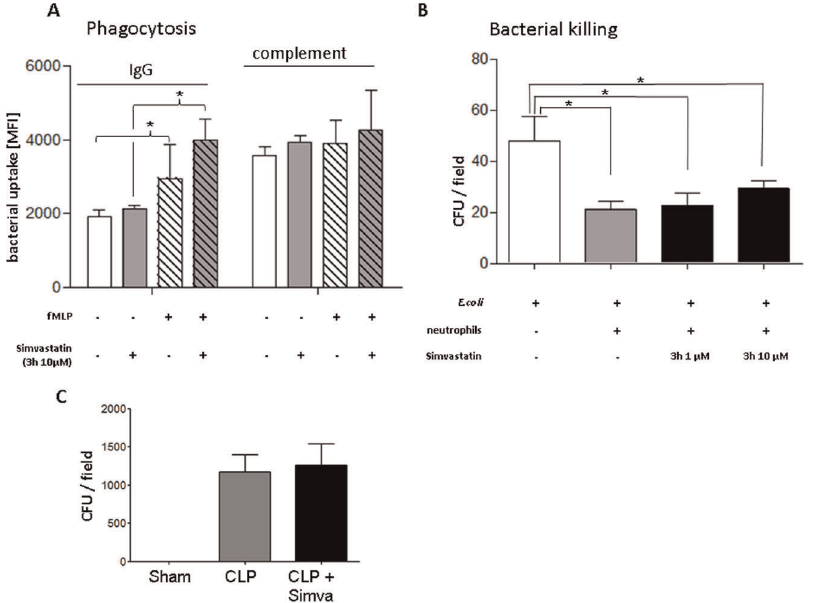
Figure 6. Simvastatin does not affect neutrophil antimicrobial activity invitro (A + B) and invivo (C). A: Bacterial uptake of fluorescent IgG- or complement-opsonized E. coli by activated or resting neutrophils as assessed by flow cytometry. Neutrophils were activated with fMLP and pretreated with simvastatin as indicated n=4; repetition=4. Statistical significance was tested using two way ANOVA with with Bonferroni posttest. * indicates significant difference to the control group without fMLP. B: Formation of colony forming units (CFU) after hypotonic lysis of neutrophils that had phagocytozed E. coli (BL21) for 20 min. (n=4). C No negative effect on neutrophil bacterial clearance in acute lung injury. 24 h after cecal ligation and puncture (CLP), the supernatant of the harvested lungs was spread out on Luria Bertani agar over night and the colony forming units (CFU) were enumerated. The CFU did not increase after simvastatin treatment in comparison to the CLP group indicating no negative effect on the bacterial clearance (n=5). Statistical significance was tested using one way ANOVA with Newman-Keuls Multiple Comparison test. * indicates significant difference to the control group without neutrophils.